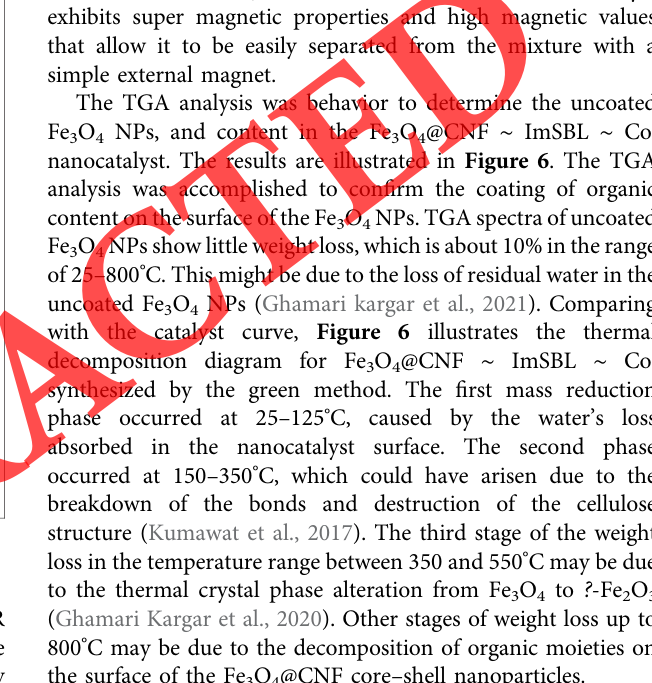
FIGURE 3 | Particle size distribution histogram of Fe 3 O 4 @CNF ∼ ImSBL ∼ Co.